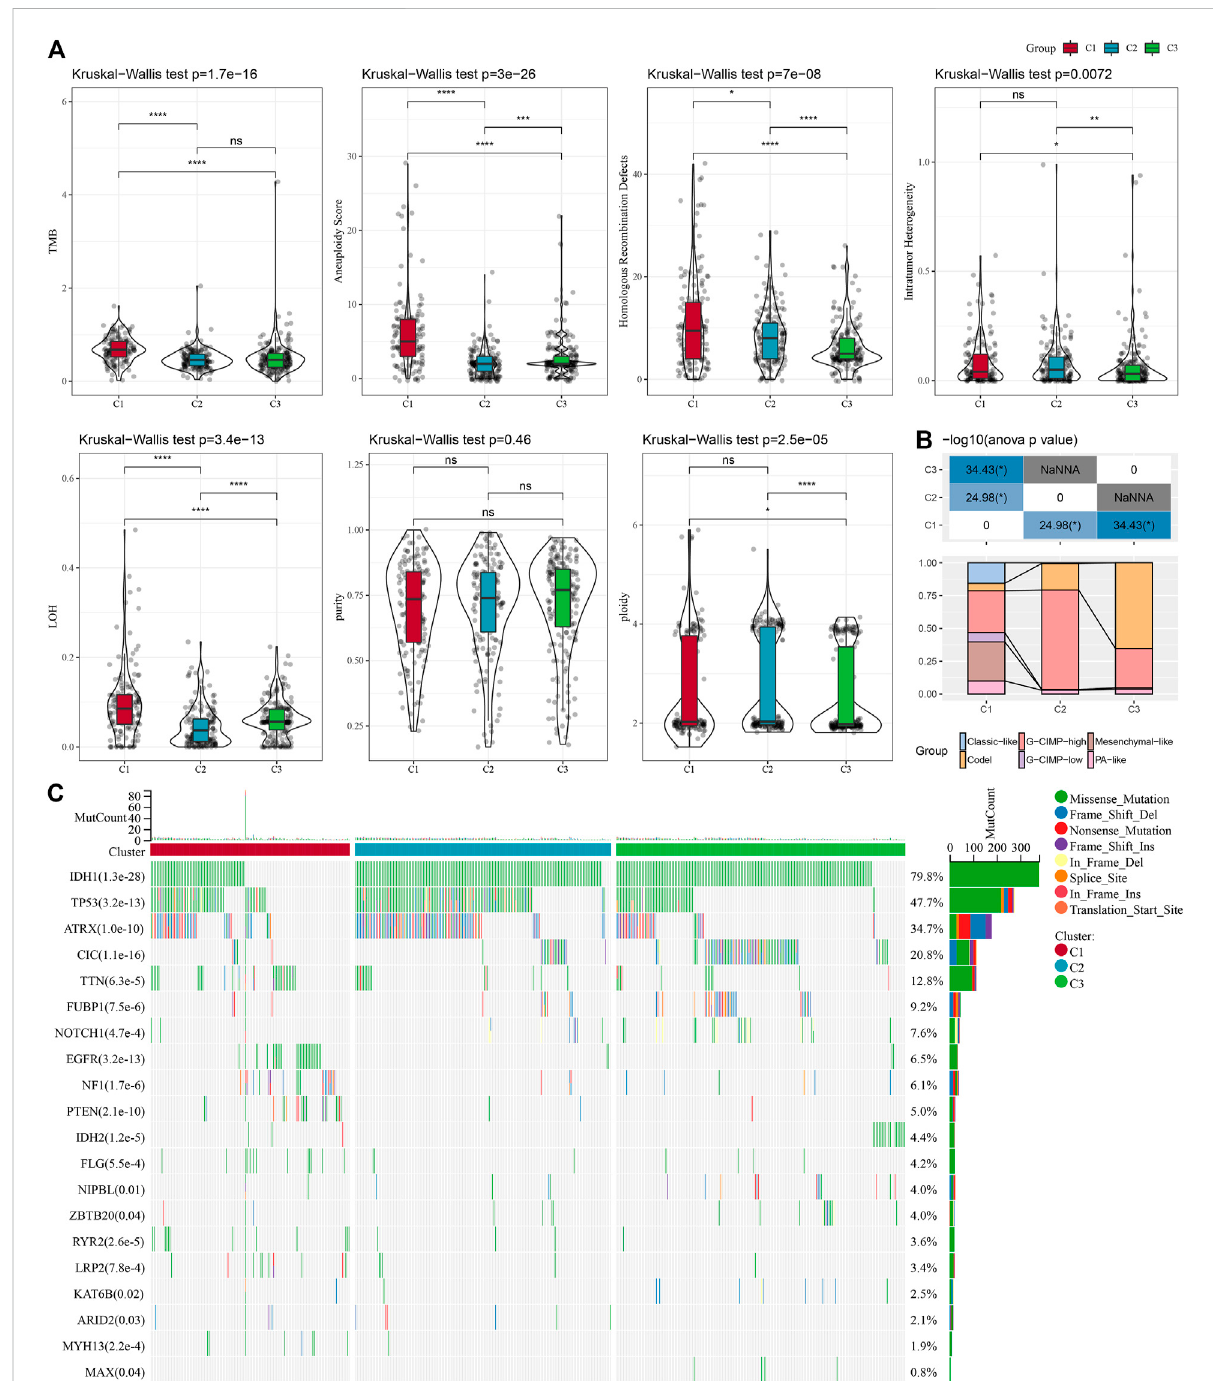
FIGURE 3 Mutation load in different molecular subtypes: genomic alterations in molecular subtypes of TCGA cohort. (A) Comparison of Tumor mutation burden, Aneuploidy Score, Homologous Recombination Defects, Intratumor Heterogeneity,LOH,purity, ploidy. (B) Comparison of the three molecularsubtypeswithimmunemolecularsubtypes. (C) Somaticmutationsinthethreemolecularsubtypes(chi-squaretest).* p < 0.05;** p < 0.01; *** p < 0.001; and **** p <